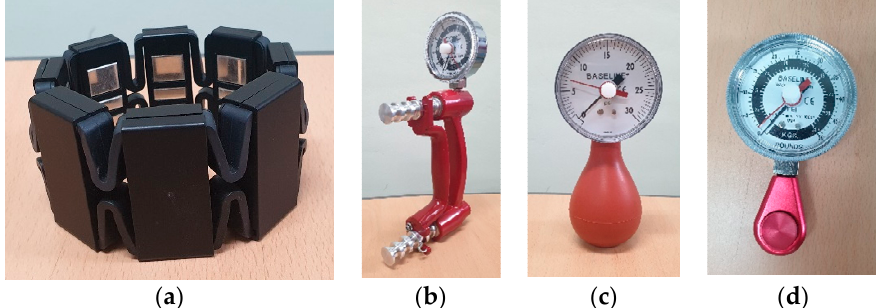
Figure 1. Armband-type multi-channel sEMG sensor ( a ) and hand dynamometers ( b – d ).